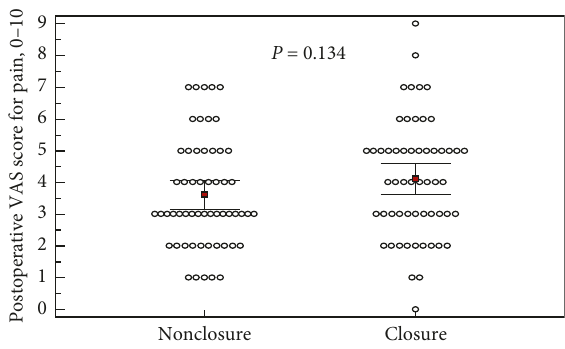
Figure 2: Postoperative VAS scores for pain. VAS scores for pain at postoperative day 1 are also shown. Each group includes 56 pa- tients. Square plots show mean values (3.6 vs. 4.1) and horizontal lines show confidence intervals (3.16–4.04 vs. 3.6–4.6) at 95% level. p value calculated using a Mann–Whitney U test.